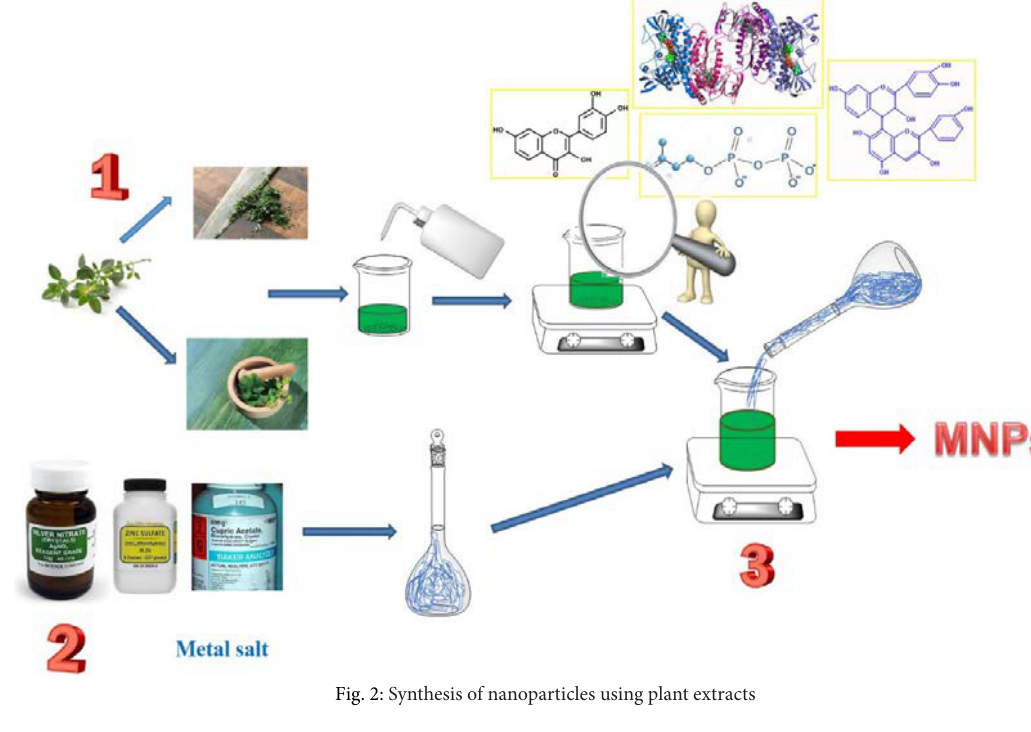
Fig. 2: Synthesis of nanoparticles using plant